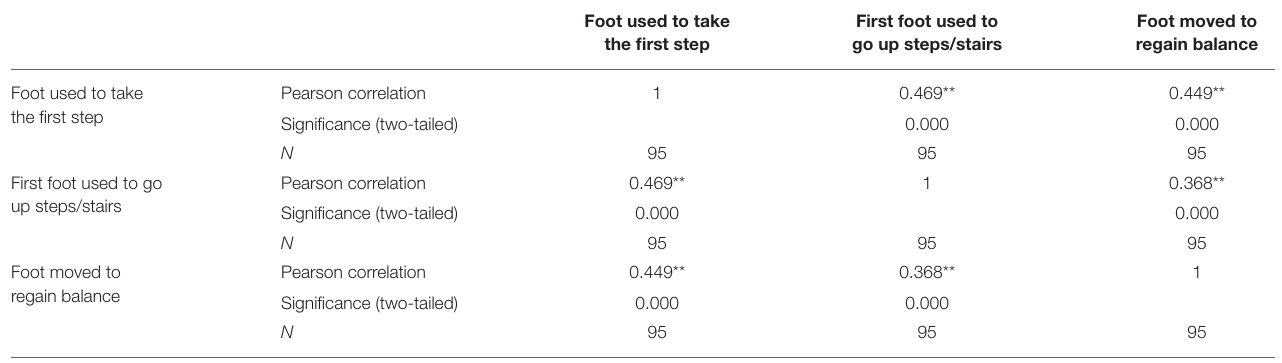
TABLE 5 | Significant correlations between specific motor skills involving locomotion skills.